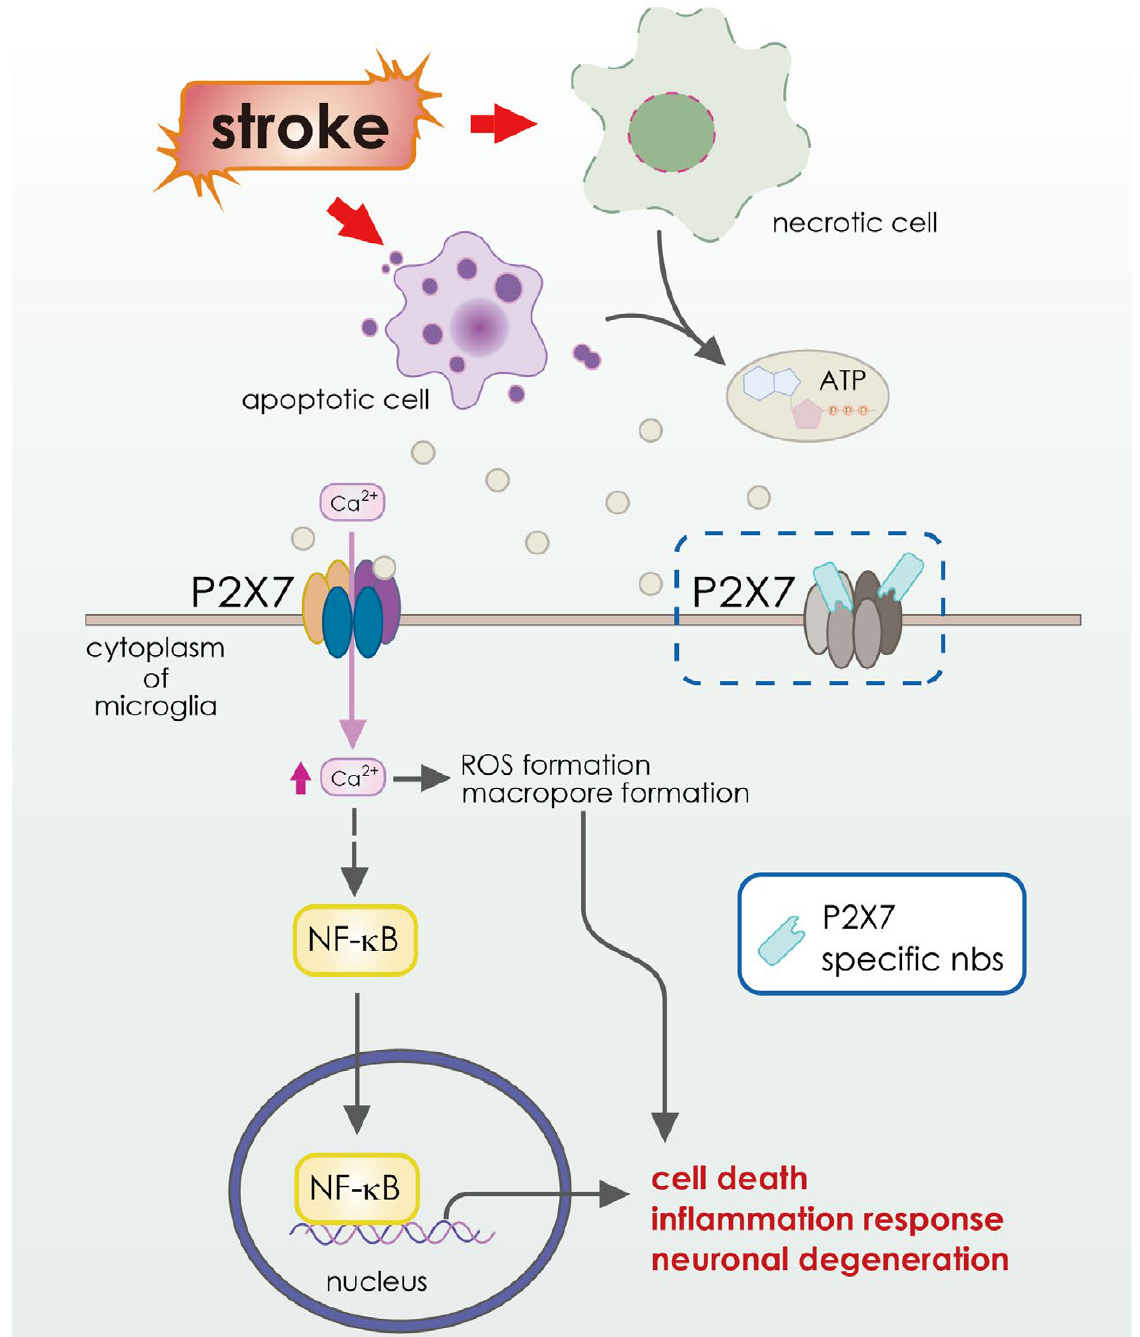
Figure 6. Schematic illustration of ATP and P2X7 signaling cascades in the pathology of cerebral ischemia. Under cerebral ischemia, energy deprivation causes anoxic and irreversible depolariza- tion, which leads to excessive release of glutamate and ATP. ATP could act as a damage-associated molecular pattern (DAMP) that activates P2X7 receptors on both neurons and glia cells. Neuronal-expressed P2X7 receptors initiate calcium overload and extensive excitotoxic neurological injury. On the other hand, microglia-expressed P2X7 receptors regulate its aberrant activation and over-production of reactive oxygen species and pro-inflammatory cytokines. These ATP-P2X7 signaling cascades modulate immune responses, ROS production, and eventually progressive neurological damage.